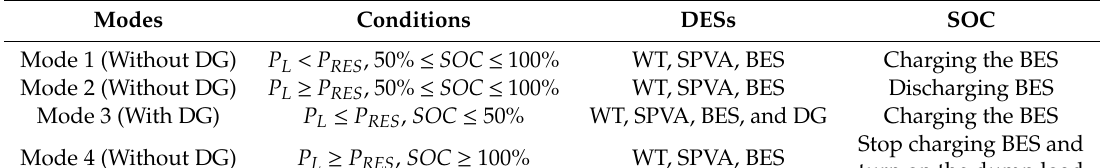
Table 1. Operation modes for o ff -grid configuration based on SPVA, DG, and WT.